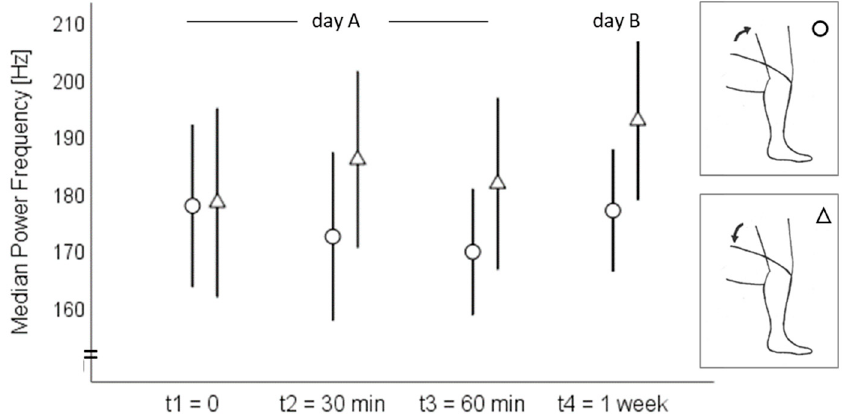
Figure 5. Means and 95% confidence intervals of the median power frequency (Hz) at the patella during standing up (circles) and sitting down (triangles).